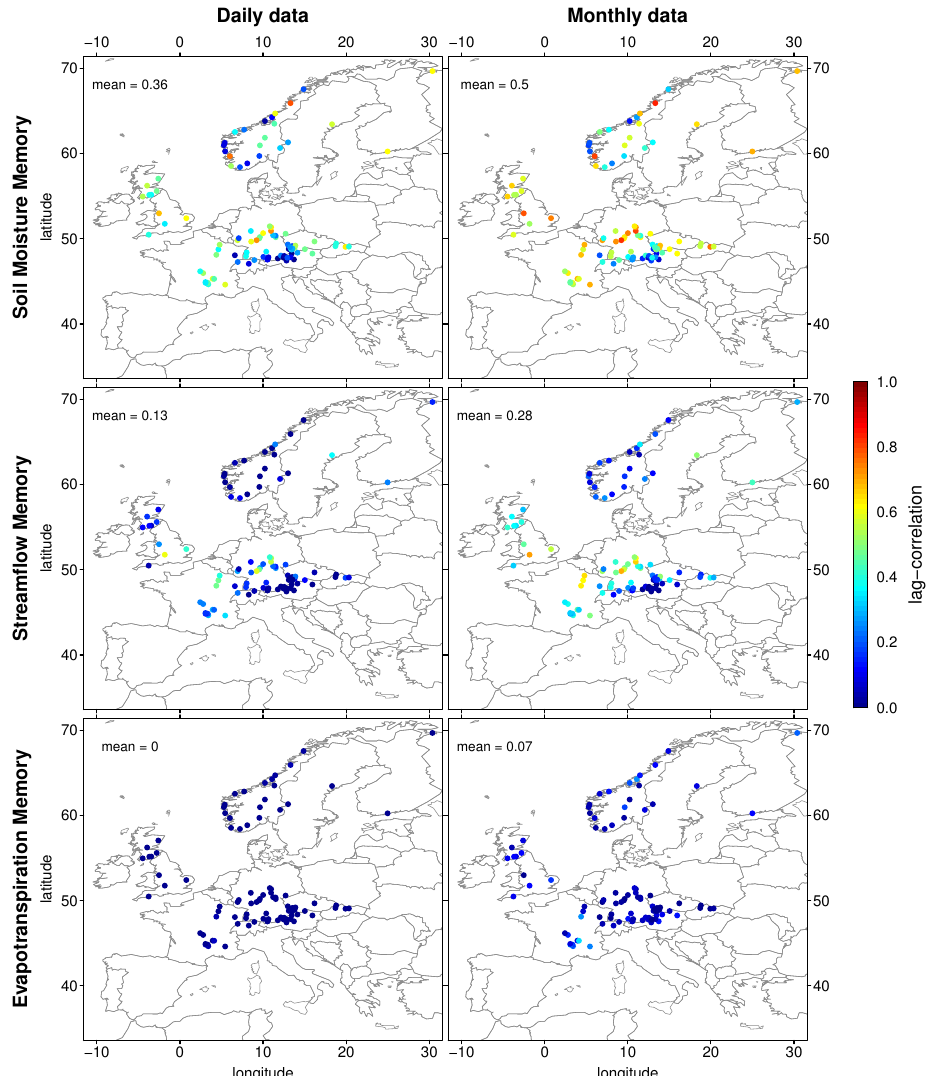
Fig. 5. Geographical distribution of mean May–September memories of soil moisture ( ρ (cid:0) w n ,w n + lag (cid:1) , upper row), streamflow Figure 5: Geographical distribution of mean May-September memories of soil moisture ( ρ ( w n ,w n + lag ) , upper (cid:16) (cid:17) row), streamflow ( ρ ( Q n ,Q n + lag ) , center row) and ET ( ρ ( E n ,E n + lag ) , lower row) for daily and monthly averaged Q n ,Q n + t ( ρ , centre row) and ET ( ρ (cid:0) E n ,E n + lag (cid:1) , lower row) for daily and monthly averaged data (all memories computed for a lag data (all memories computed for a lag of 30 days (daily data) or 1 month (monthly data)) computed as described lag of 30 days (daily data) or 1 month (monthly data)) computed as described in Sect. in Section 2.3.